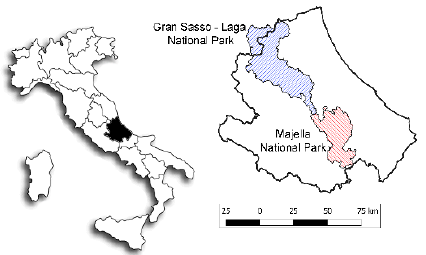
Figure 1. Geographical position of the Majella and Gran Sasso-Laga National Parks .